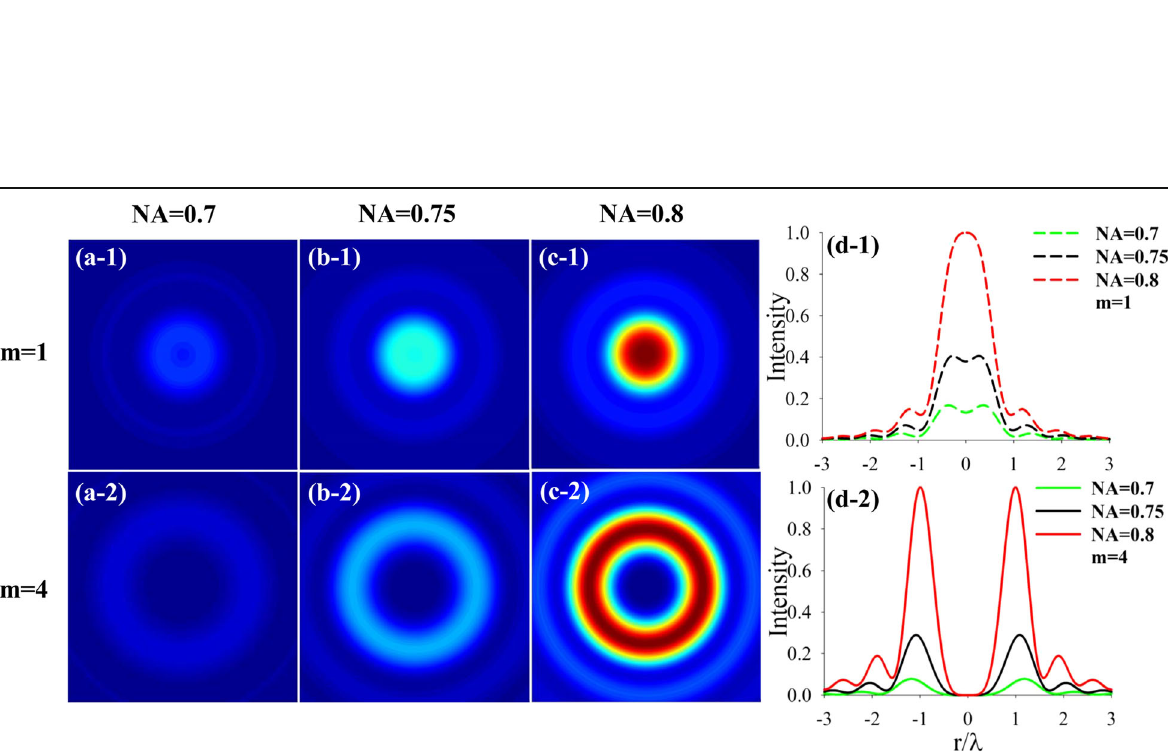
Fig. 3 Variation of the intensity with the different NA of the left-hand CPAVBs with m = 1 and m = 4, respectively. a-1 and a-2 , b-1 and b-2 , and c-1 and c-2 are NA = 0.7, 0.75, 0.8, respectively. d-1 and d-2 Cross-section of the